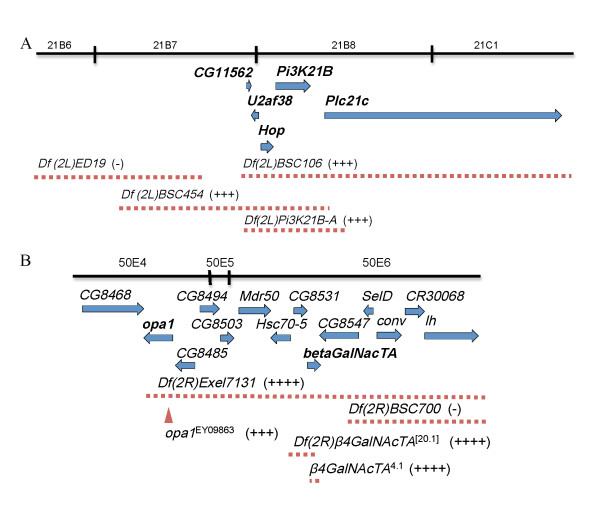
Molecular characterization of two PD suppressor-containing cytological regions 21B7-21C2 and 50E4-50F6. A, Characterization of the PD-interacting cytological region 21B7-21C2. B, Characterization of the PD-interacting cytological region 50E4-50F6. The regions uncovered by the deficiencies used in the experiments are indicated (dashed line). The effect of each deficiency is indicated as suppression (+) or no suppression (-). The genes (arrows) are listed according to their genomic location. opa1EY09863 is an opal loss-of-function allele in which a P-element-containing sequence is inserted into the opa1 locus. Df(2R)β4GalNAcTA[20.1] and β4GalNAcTA4.1 were generated by imprecise excision [47]. In the Df(2R)β4GalNAcTA[20.1] allele, both β4GalNAcTA and CG8531 are deleted, while 610 base-pair sequence in the β4GalNAcTA gene is deleted in the β4GalNAcTA4.1 allele.